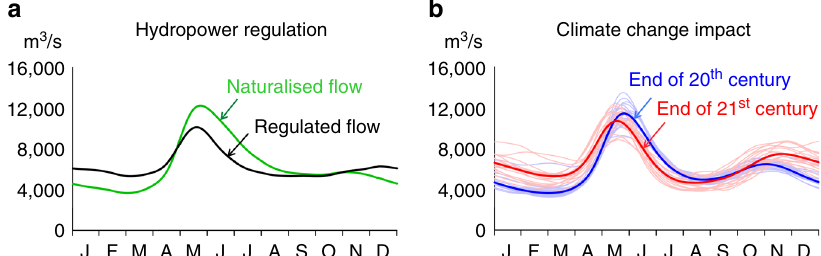
Fig. 1 Impact from hydropower and climate change on river- fl ow regime for entire Sweden. Seasonal distribution of total river runoff from Sweden (450,000 km 2 ), with and without impact of: a extensive hydropower regulation, and b projected climate change (using a climate-model ensemble of 18 members, where the mean is bold ). Smoothed 30-yr means of daily values are shown. The climate impact modelling was based on CMIP5 projections for the representative concentration pathways (RCP) 4.5 and 8.5 from: CanESM2, CNRM-CM5, GFDL-ESM2M, EC-EARTH, IPSL-CM5A-MR, MIROC5, MPI-EMS-LR, NorESM1-M, HadGEM2-ES. Each ensemble member was downscaled using RCA 62 and bias adjusted using DBS